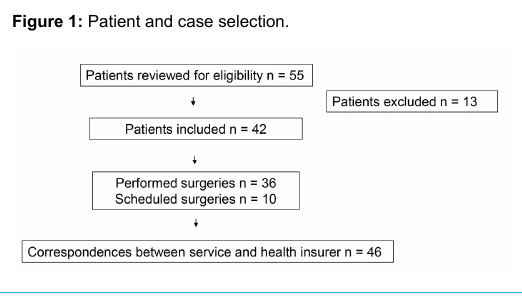
Figure 1: Patient and case